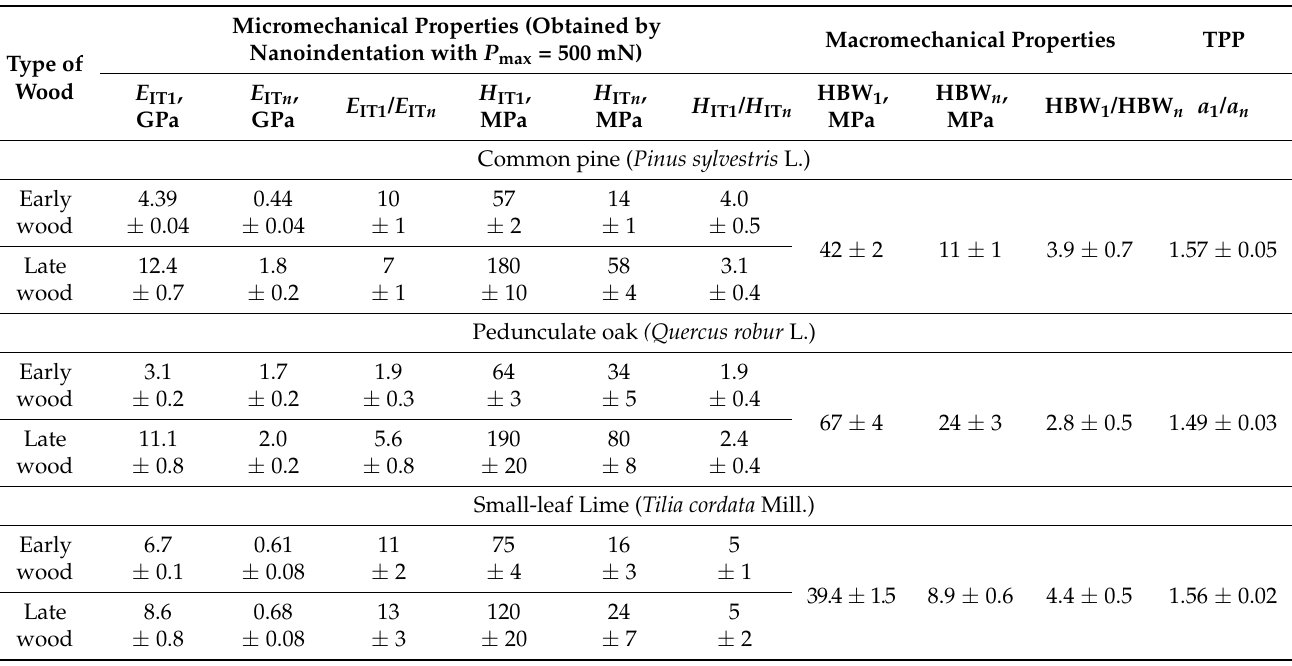
Table 1. Measured micro-/macromechanical and thermal physical properties of wood of the three studied species.